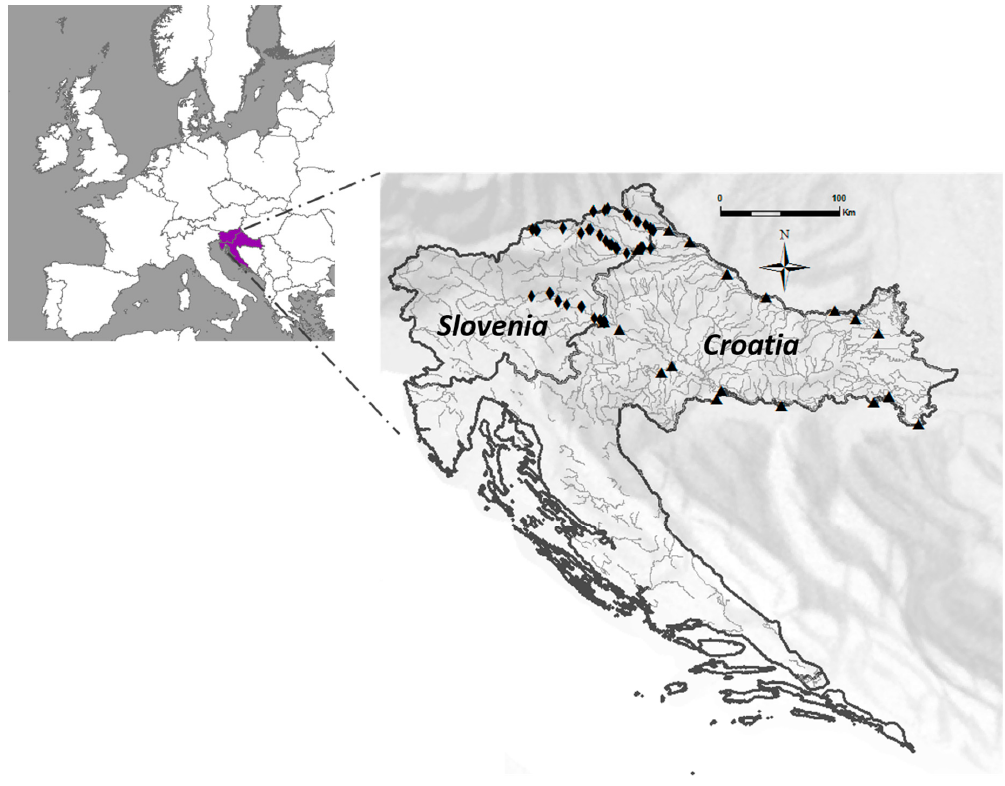
Figure 1. Study area showing the examined larger rivers and sampling sites (diamonds).